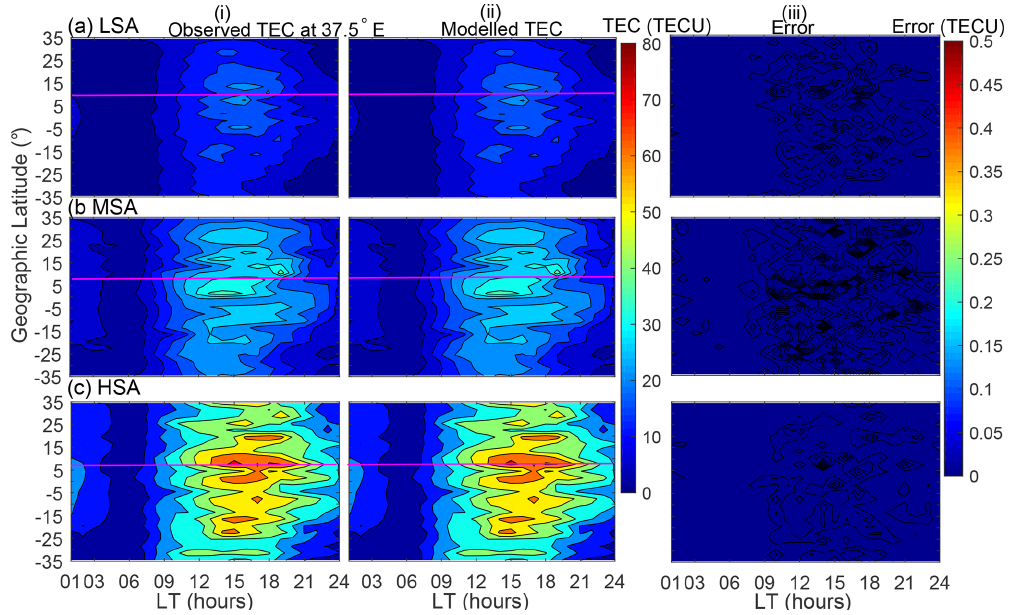
Figure 2. Variation of TEC as a function of geographic latitude and local time in the March equinox at 37.5 ◦ E. Panels in rows (a–c) corre- spond to LSA, MSA, and HSA, respectively, while panels in columns (i)–(iii) correspond to observed binned TEC, modeled TEC, and the difference between observed and modeled TEC (errors), respectively. The magenta line indicates ∼ 0 ◦ dip